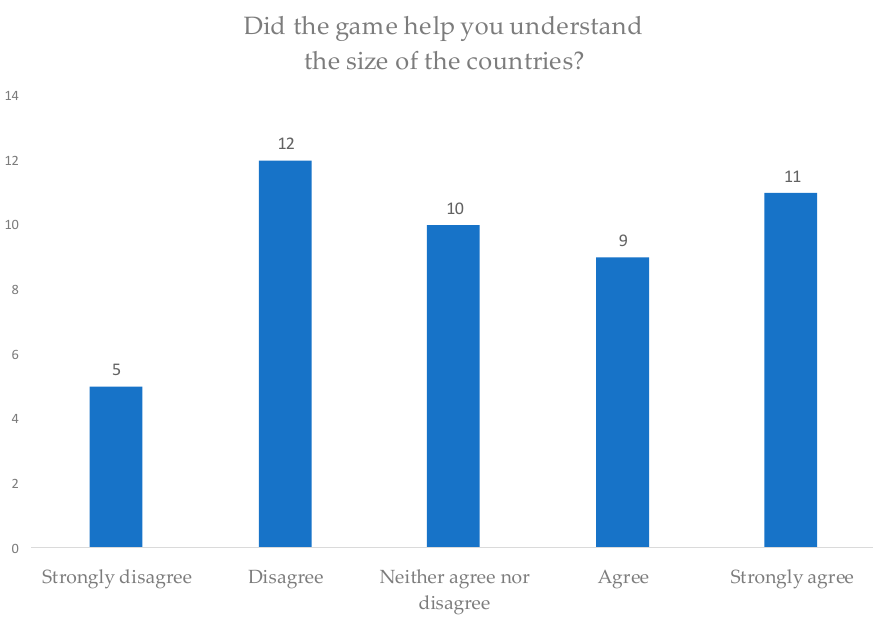
Figure 12. Self-reported perception of academic performance. Big Data Cogn. Comput. 2020 , 4 , x FOR PEER REVIEW